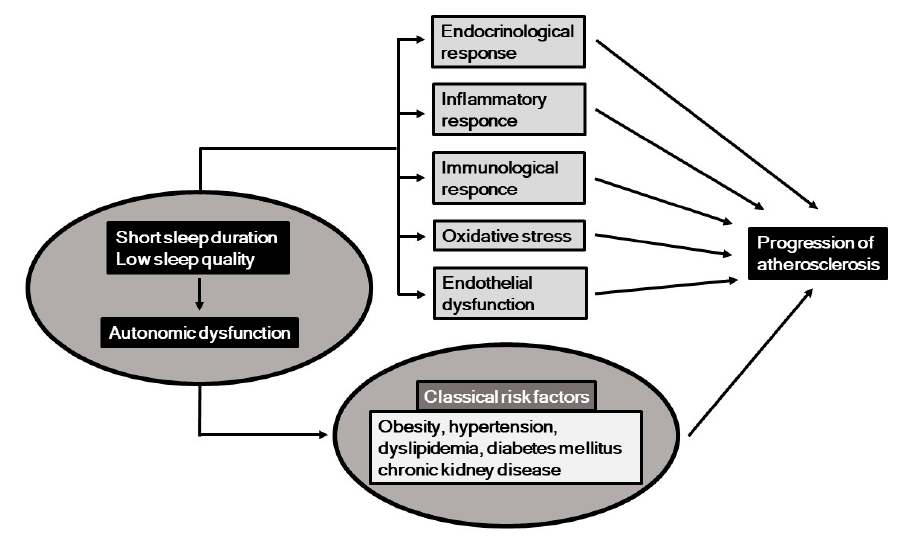
Figure 1. Short sleep duration and low sleep quality, along with resultant autonomic nervous dysfunction may induce progression of atherosclerosis, potentially through endocrinological, immunological, inflammatory, and oxidative response, and endothelial dysfunction.